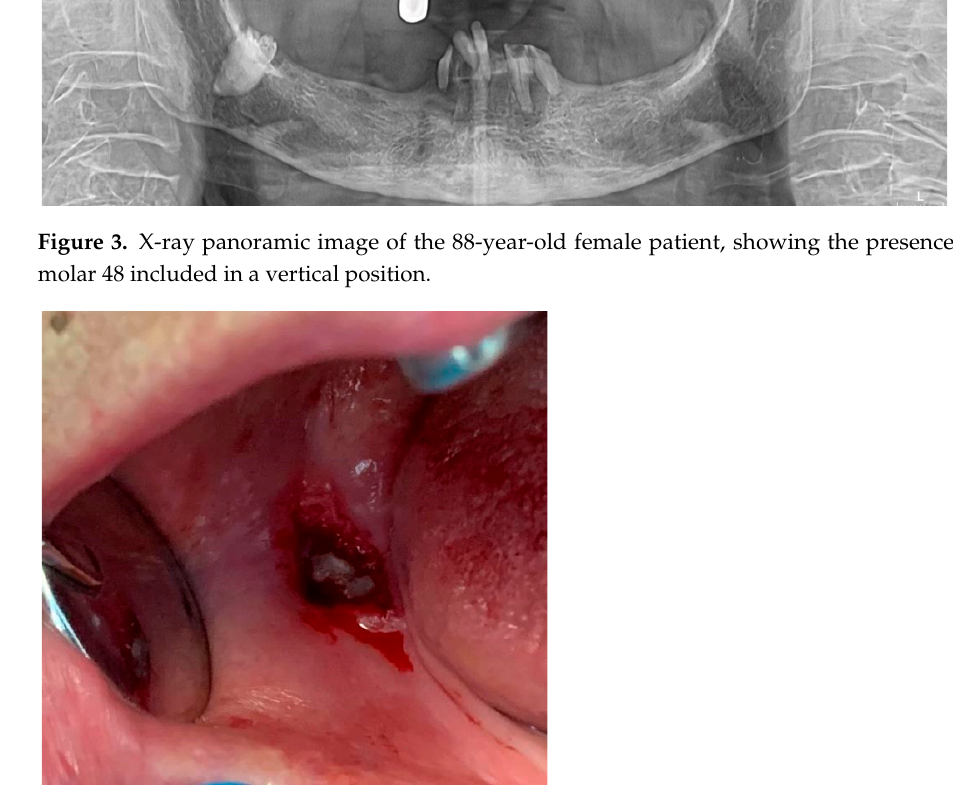
Figure 4. The affected area after the operculectomy.